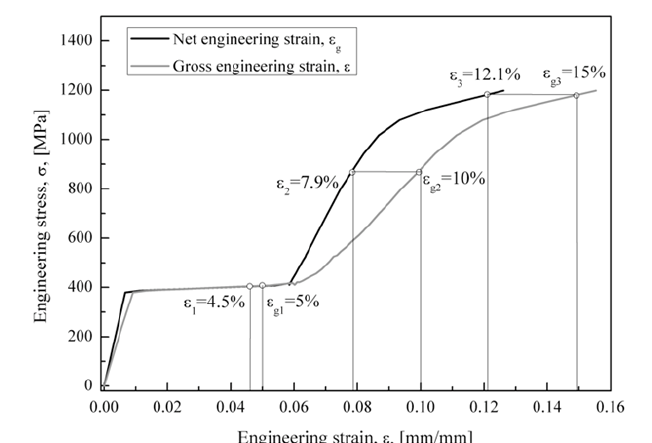
Figure 7: Relation between gross and net engineering strain obtained from FE simulations.